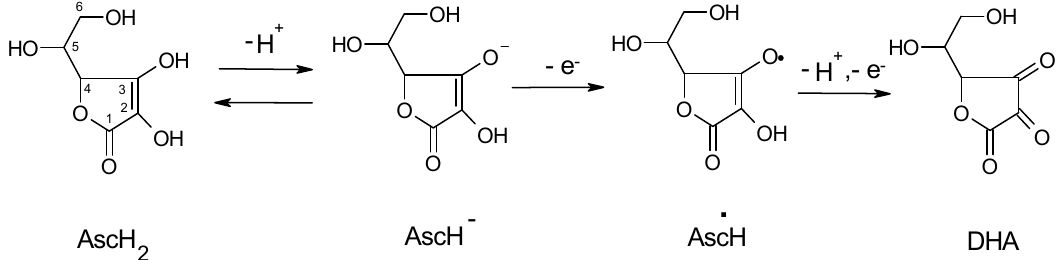
Scheme 1. The structure of ascorbic acid and the main products of redox reactions. Ascorbic